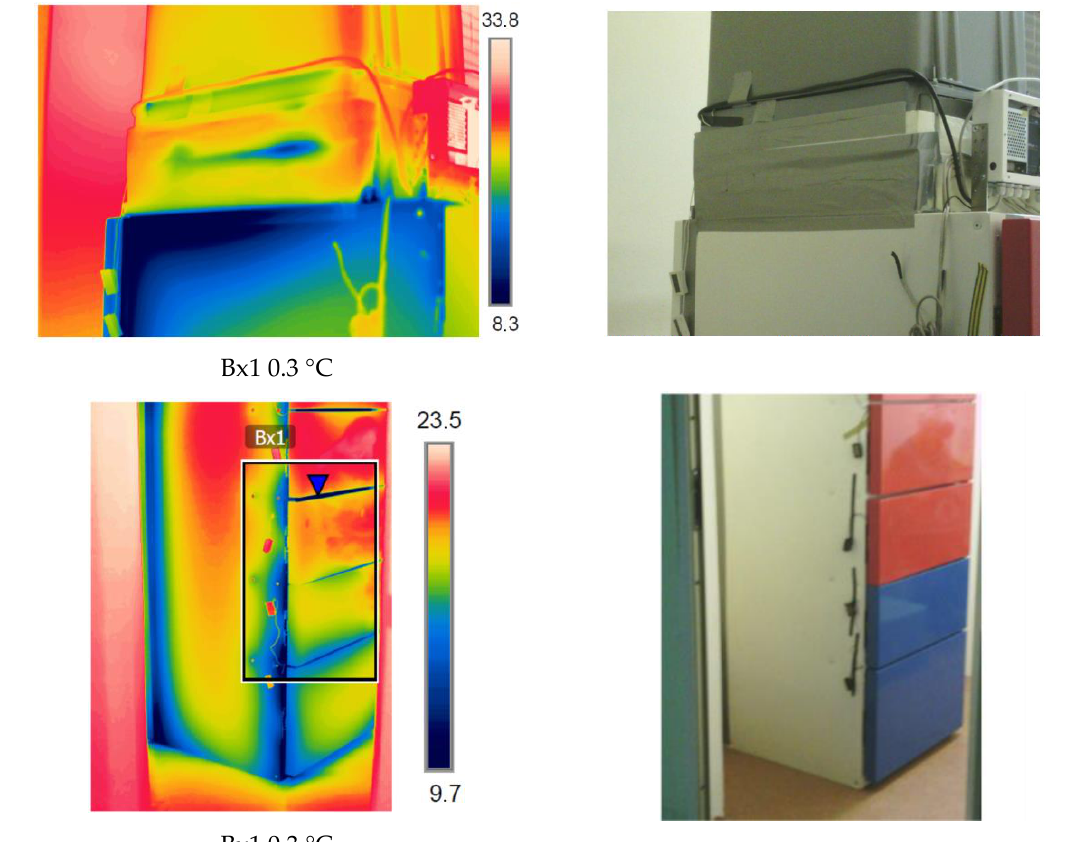
Figure 13. Thermograms of the freezing module—thermal bridges on the side wall of the module and insulation caused leakage between the module and the monoblock .